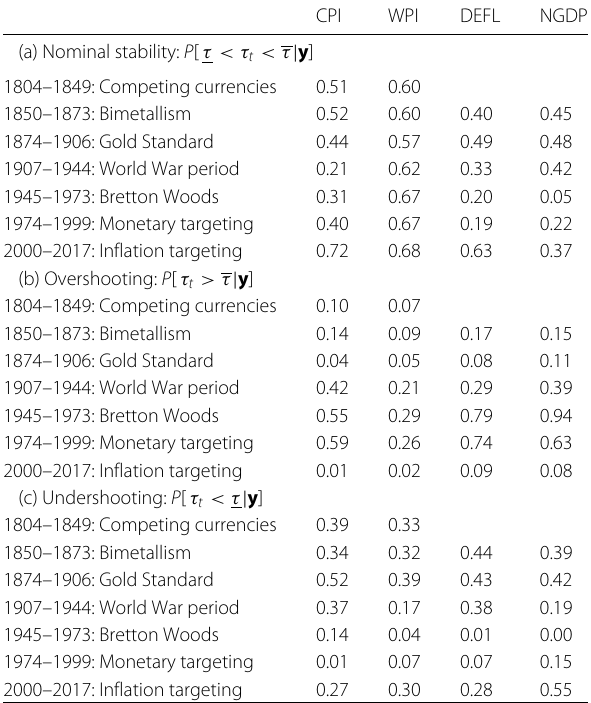
Table 7 Probability of nominal stability (UC-SV model) CPI WPI DEFL